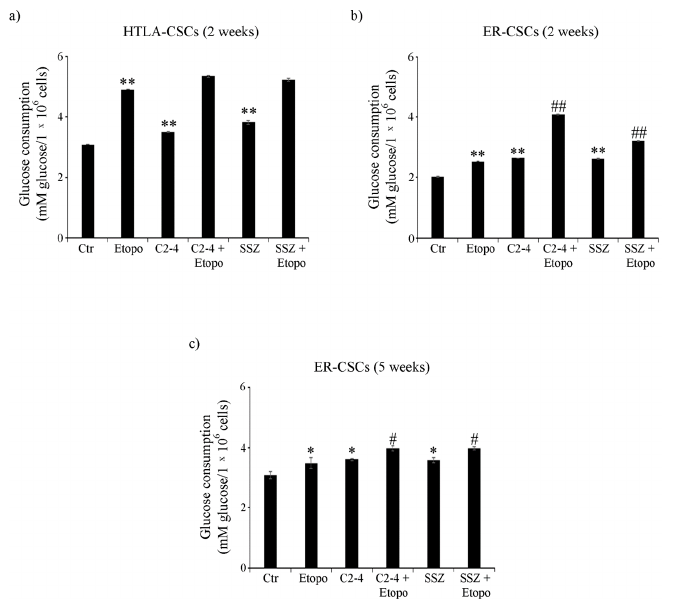
Figure 6. Glucose consumption in both CSC populations treated for two ( a , b ) or five weeks ( c ). HTLA-CSCs and ER-CSCs were treated three times a week with 0.1 µM C2-4, with 5 µM SSZ or with 1.25 µM Etoposide, administered once a week alone or in combination with C2-4 or SSZ. Results were reported as mM glucose/10 6 cells. Bar graph summarizes quantitative data of means ± S.E.M. of three independent experiments. * p < 0.05 vs. untreated CSCs (Ctr); ** p < 0.01 vs. untreated CSCs (Ctr); # p < 0.05 vs. Etoposide-treated CSCs; ## p < 0.01 vs. Etoposide-treated